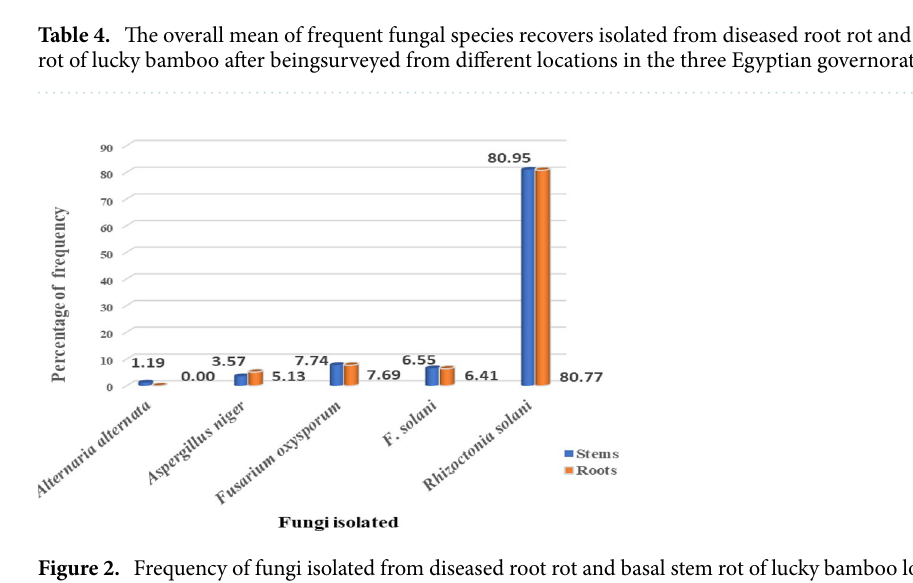
Figure 2. Frequency of fungi isolated from diseased root rot and basal stem rot of lucky bamboo located in different locations in three Egyptian